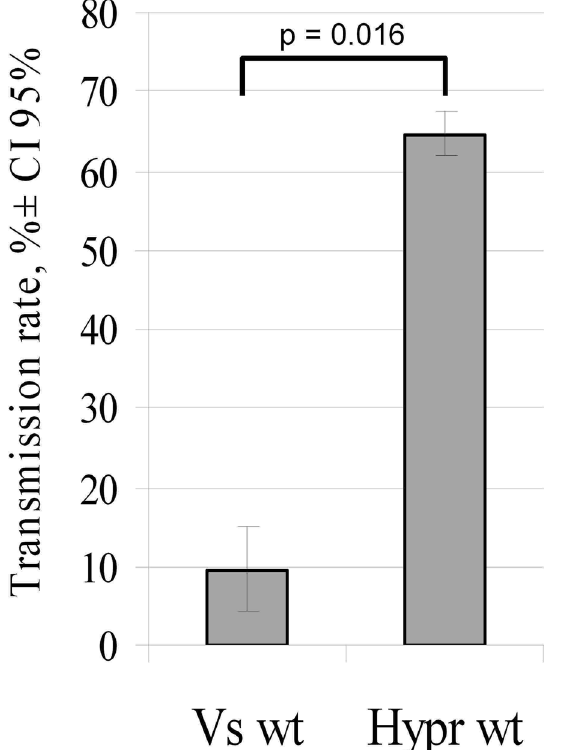
Fig 1. Efficiency of non-viraemic transmission of SIB-TBEV (Vs) and EU-TBEV (Hypr) between co- feeding I . ricinus . Two infected female ticks were placed in close proximity to 15 uninfected nymphs on the same skin site of laboratory mice. Following three days of co-feeding, nymphs were removed and virus titres determined by plaque titration. The mean transmission rate is expressed as percentage of positive nymphs in which TBEV was